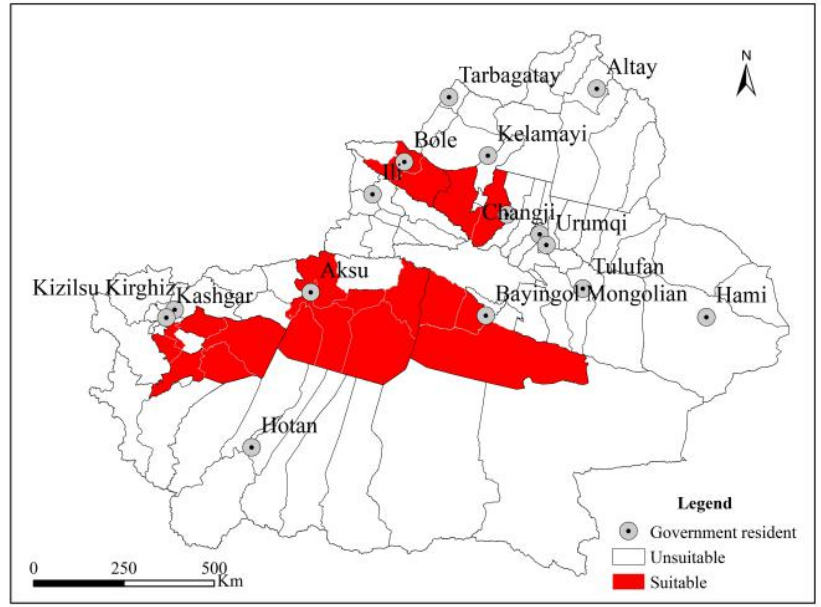
Figure 10. Suitable area for cotton seed production with regard to production history.